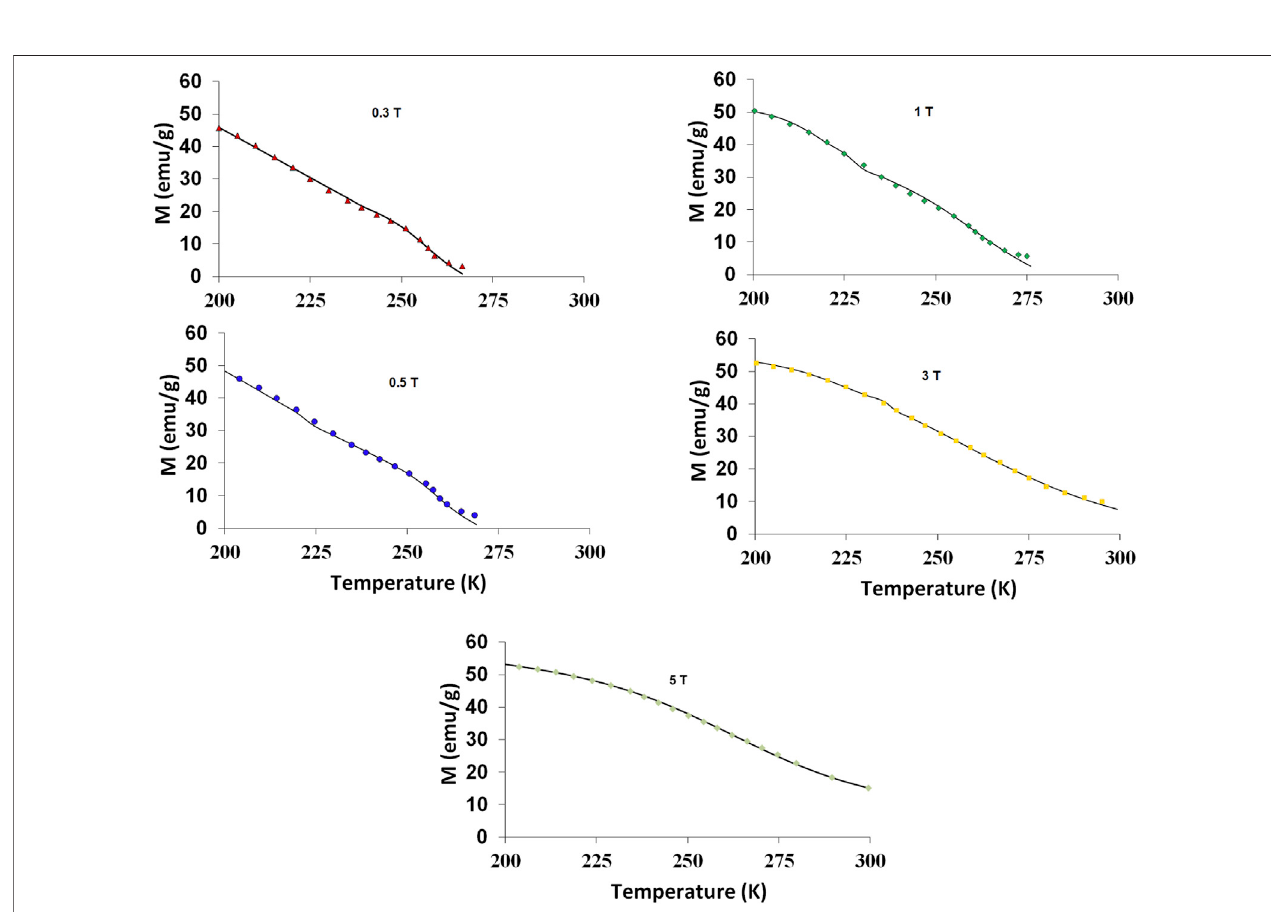
FIGURE 2 | Magnetization vs . temperature for La 0.5 Ca 0.1 Ag 0.4 MnO 3 . The dashed curves are modeled results, and the symbols represent experimental data from Jeddi et al . (2020).